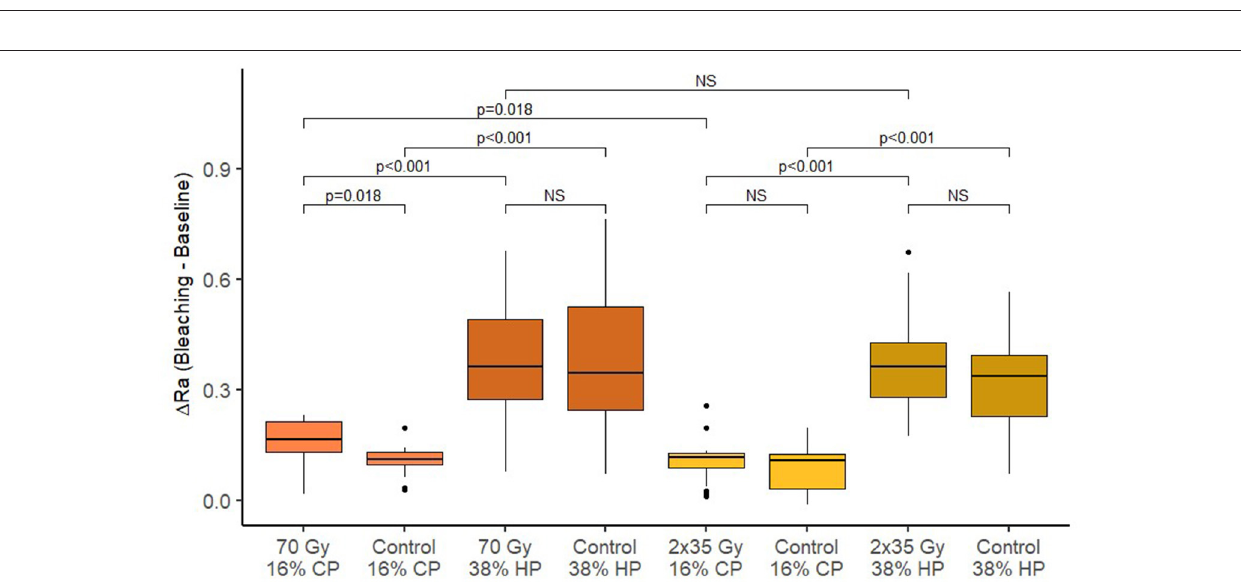
FIGURE 5 | Box-plots of changes in enamel roughness after bleaching across different treatment groups.